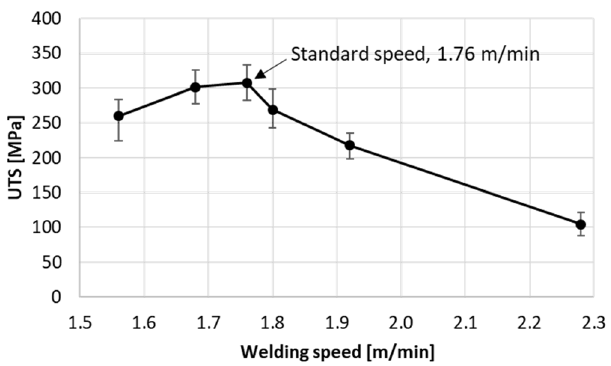
Figure 6. Influence of welding speed on the UTS of the welding